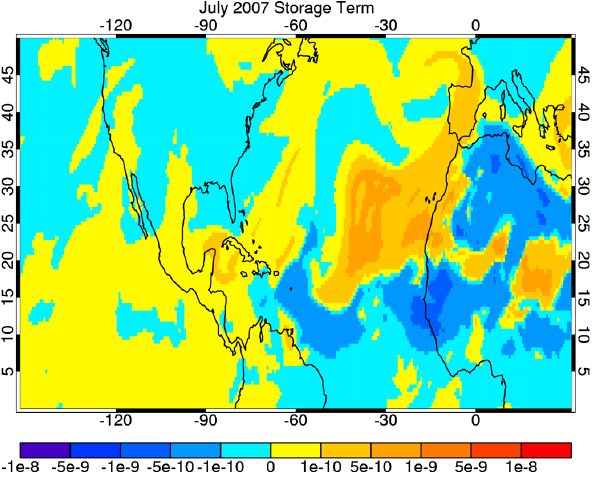
Fig. 9. July 2007 production minus loss (P-L) term (kgm − 2 s − 1 ) as described in Sect.